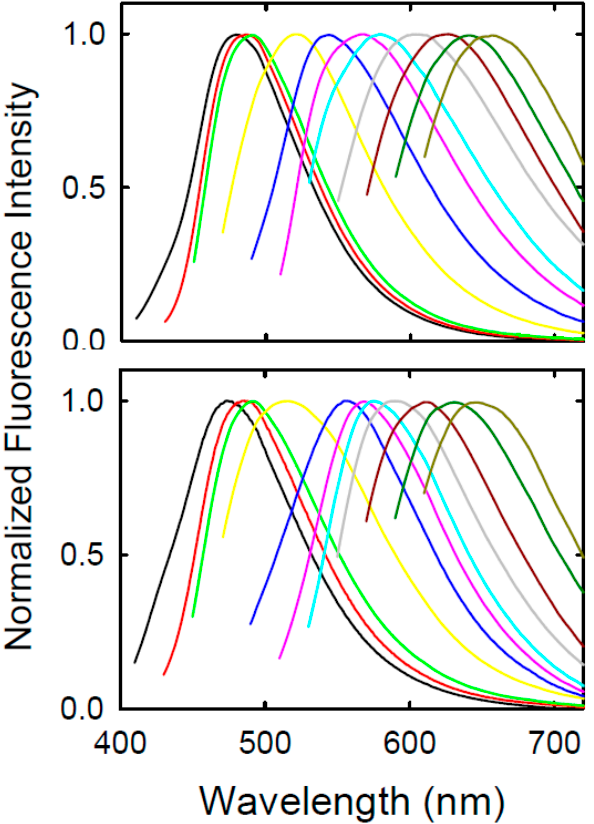
Figure 4. The excitation wavelength dependence of fluorescence emissions for CS330 (upper) and CS MT (lower) in aqueous solutions, with the excitations of 400 nm and (from left to right) in 20 nm increments (thus 600 nm excitation for the last spectrum at right).